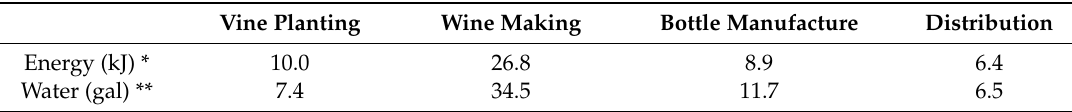
Table 2. Data inventory for greenhouse gas emissions (g CO 2eq ) for various stages of wine making per functional unit * . GHG * Table 1. Data inventory for energy and water consumption for various stages of wine making per functional unit * . Vine Planting Wine Making Bottle Manufacture Distribution